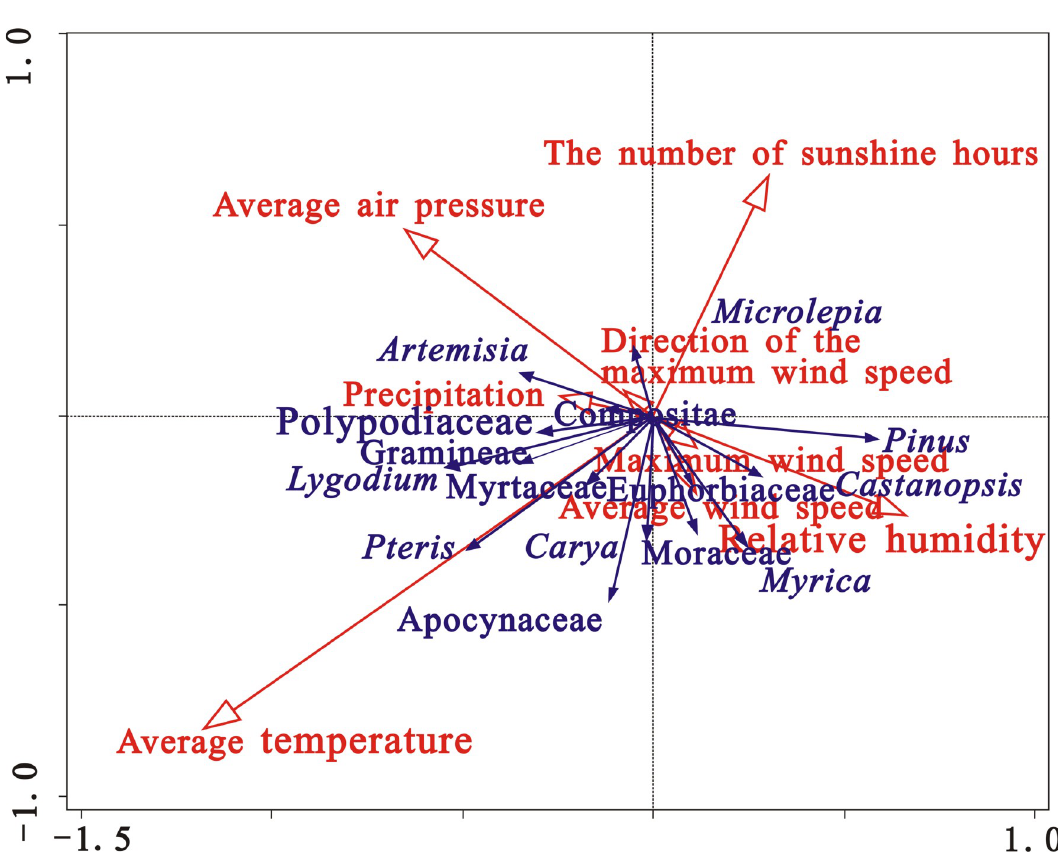
Fig 4. Results of RDA of the concentrations of major pollen types and meteorological parameters in central Zhanjiang city during 2015~2016.